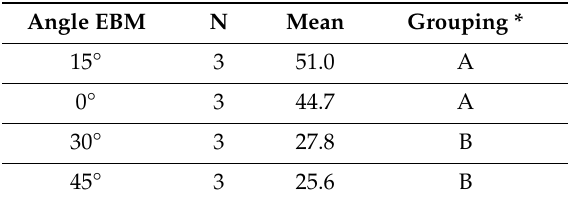
Table 6. Grouping information using the Tukey method and 95% confidence interval on the Ra measurements of the EBM samples.